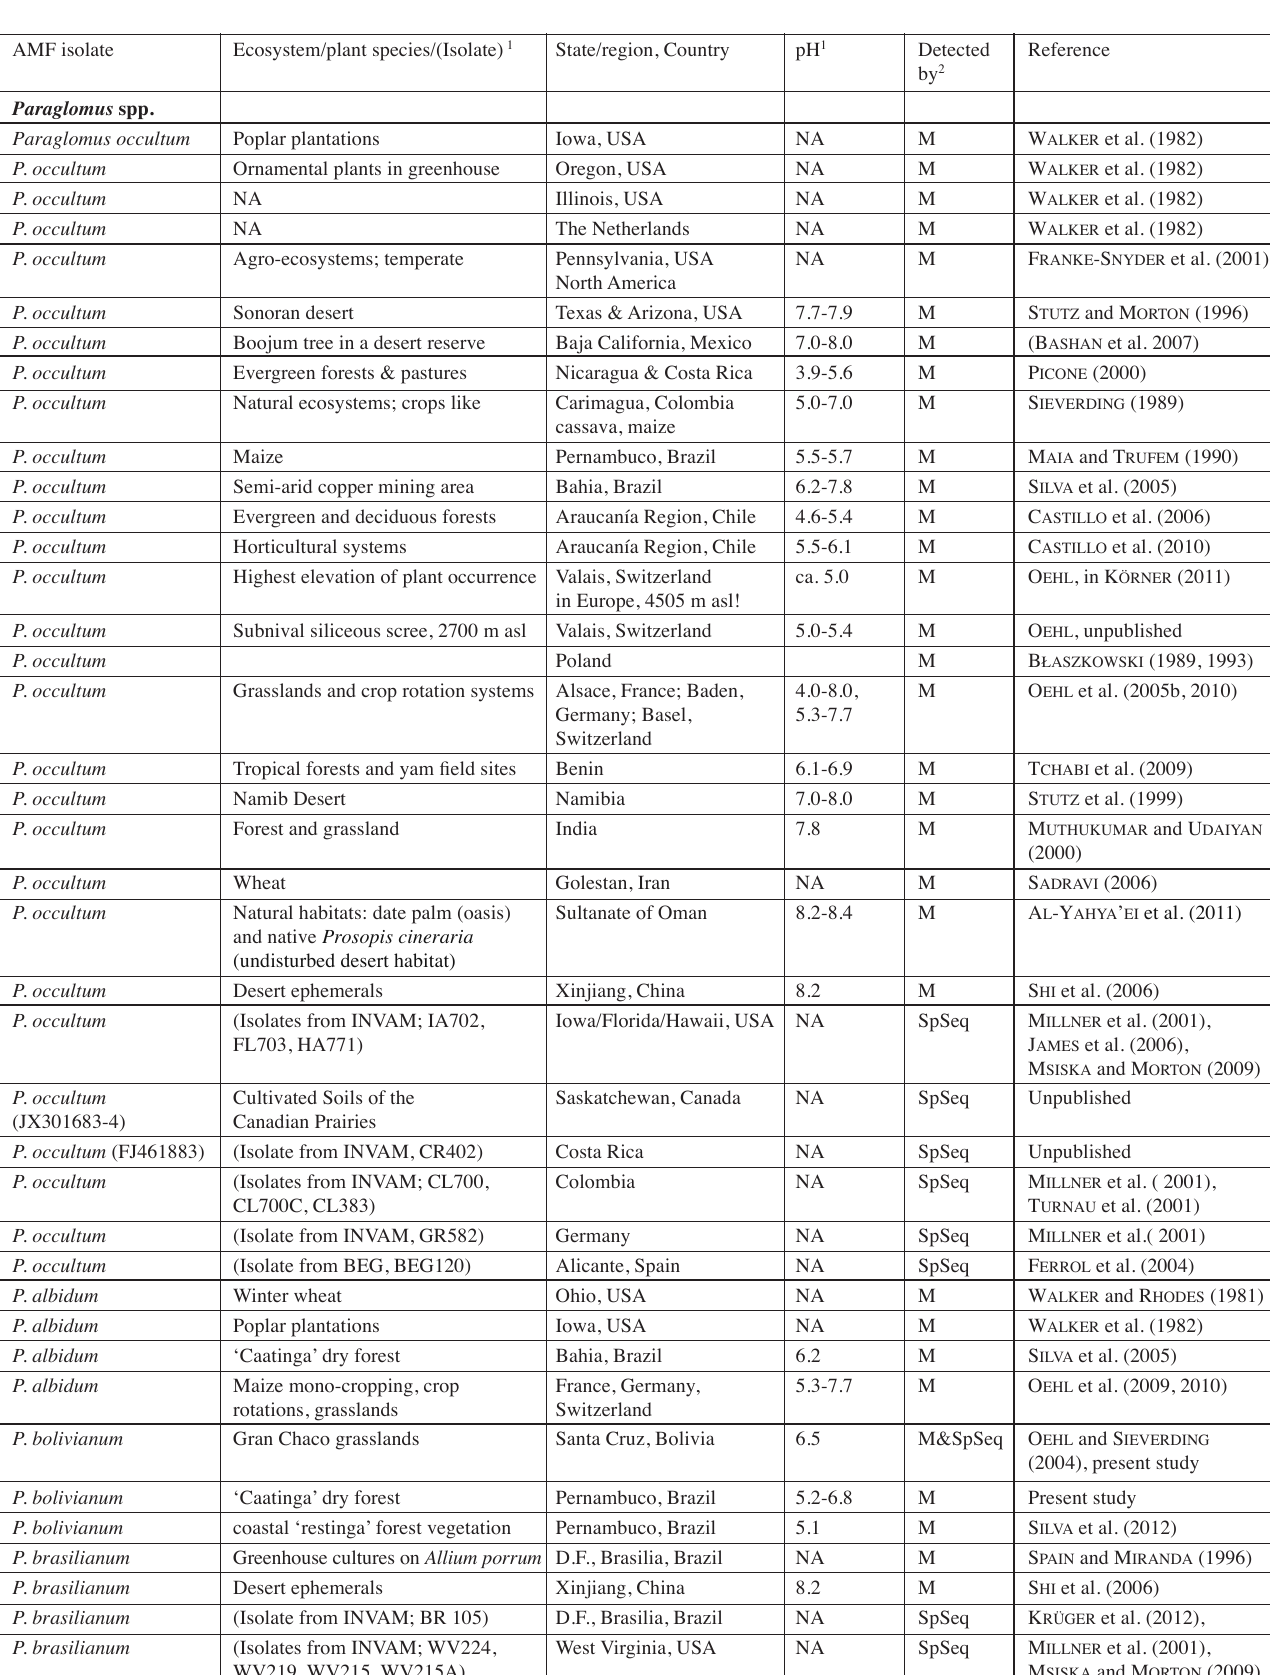
Tab. 1: Detection sites of Paraglomus and Pacispora species around the globe AMF isolate Paraglomus